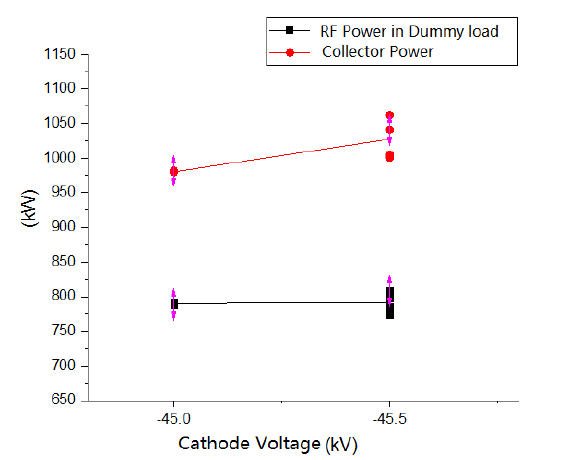
Fig. 10. Changes in the output power of the gyrotron when the magnetic field current, filament primary voltage, filament primary current, and beam voltage are 50.4A, 40.9V, 35.28A, and 68.5kV, respectively.